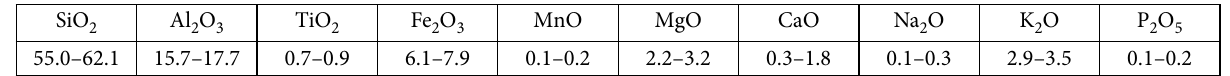
Table 2. Chemical composition of clay powder, %